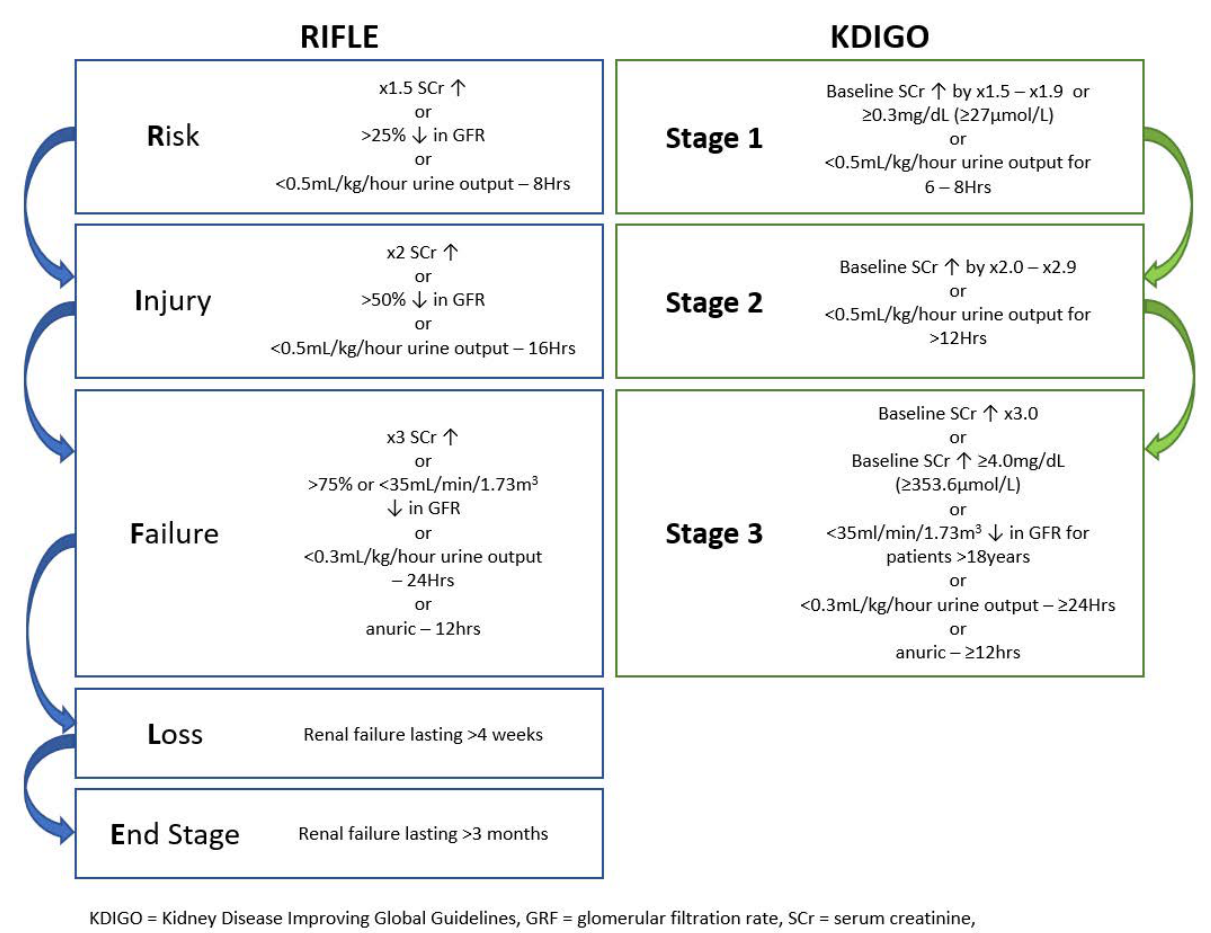
Figure 1. Outline of 2 different criteria for acute kidney injury (AKI); Risk, Injury, Failure, Loss, End- stage (RIFLE) classification ( left ) and the clinical practice guidelines published by Kidney Disease Improving Global Guidelines (KDIGO) for acute kidney injury ( right